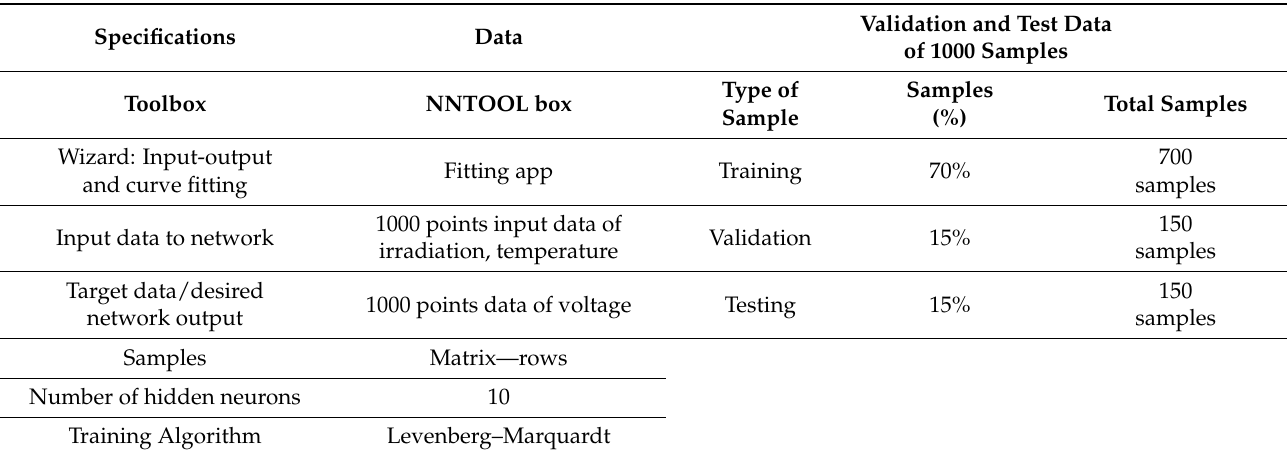
Figure 26. Flow chart of neural network MPPT. Table 4. Particulars in neural network